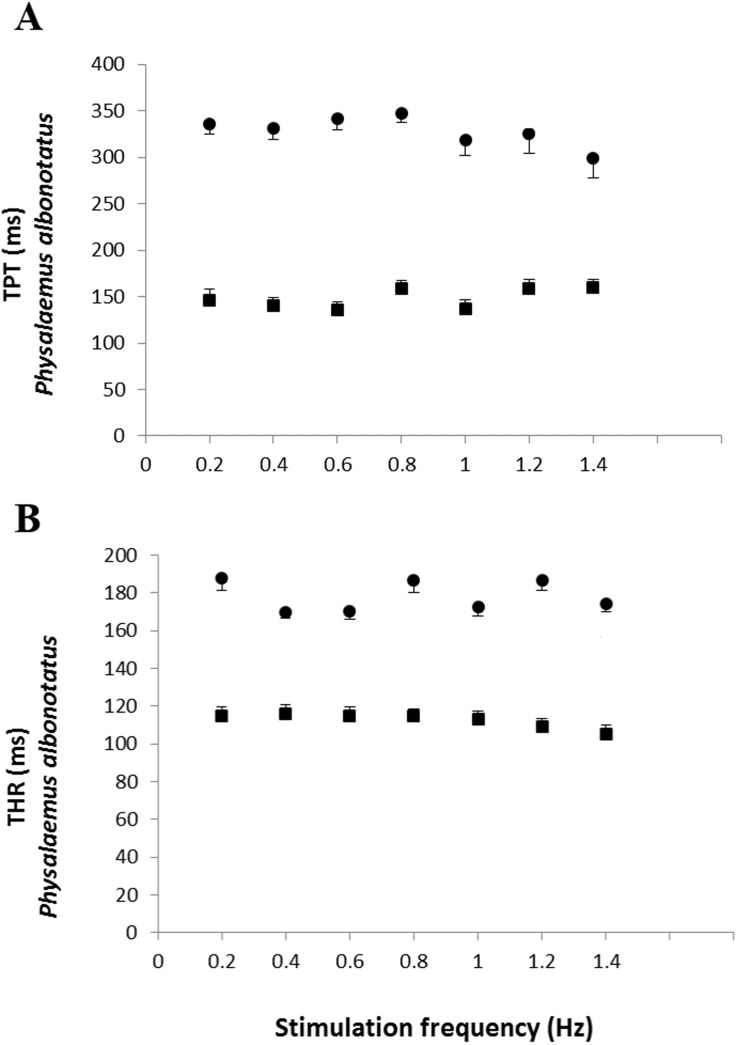
Time to peak tention and to relaxation of control and infected P. albonotatus.Effect of increased stimulation frequency over the time to reach peak tension (A: TPT - ms;) and the time to reach 50% of relaxation (B: THR - ms) of the ventricular strips of P. albonotatus (squares represent Bd− group - n = 10, and circles represent Bd+ group - n = 10). The points represent mean values ±SE. Significant differences (Dunnett’s test - P < 0.05) between different treatments (Bd− and Bd+) were observed in TPT and THR of P. albonotatus, in all stimulation frequencies. Note different scales in the figures.